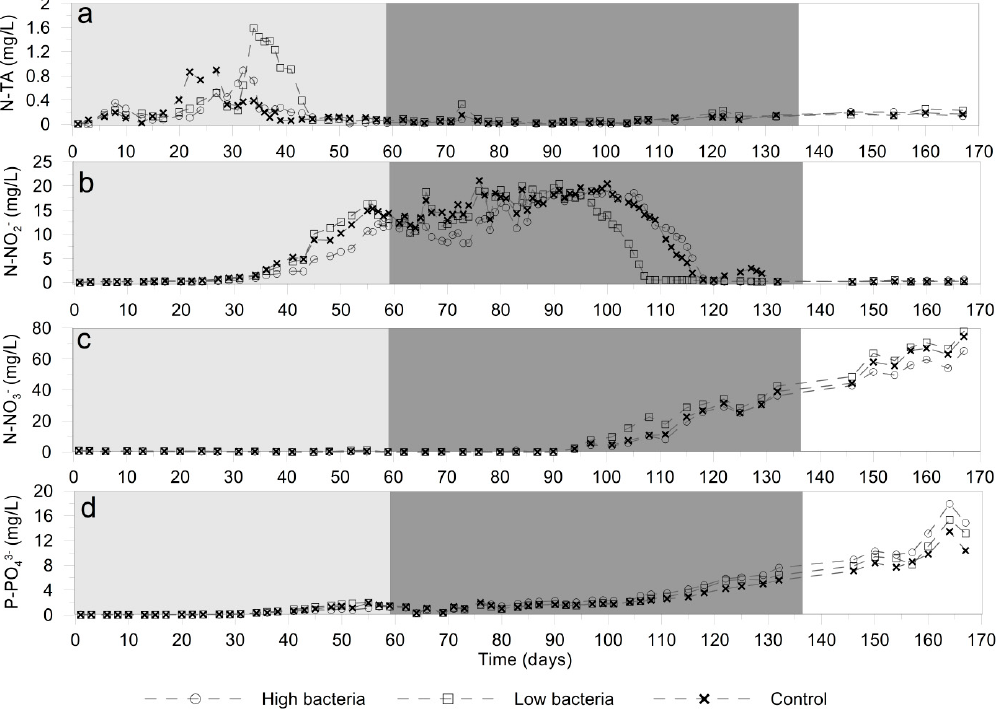
Figure 2. Evolution of nutrients, a) total dissolved ammonia, b) nitrites, c) nitrates and d) phosphates. Each data represents the average of the three experimental units for high bacteria treatment (2.8 × 10 4 cfu/mL), low bacteria treatment (2.8 × 10 3 cfu/mL) and control treatment. Between days 56 and 80 approximately 10 to 15% of water was renewed to avoid any toxic concentration of nitrite.